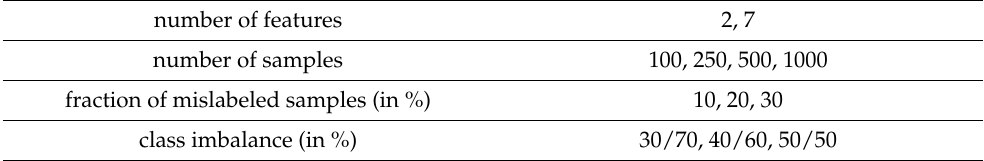
Table 2. Parameters describing synthetic datasets used for the evaluation of selected classifiers. number of